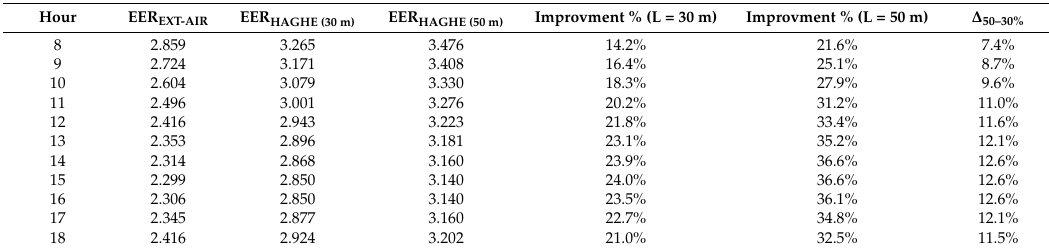
Table 8. Hourly performance improvement (%) of EER respect of untreated case by varying probe